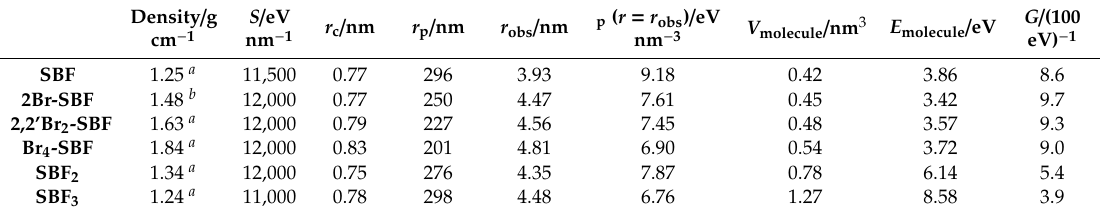
Table 2. Summary of density, calculated maximum radial range r c and r p , calculated electronic stopping power ( S ), radii in nanowire form r obs , calculated energy density at the nanowire radii ρ p ( r = r obs ) , estimated molecular volume V molecule , given energy per molecule by high-energy ions E molecule , and estimated G for SBF, 2Br-SBF, 2,2 (cid:48) Br-SBF, Br 4 -SBF, SBF 2 , and SBF 3 upon irradiation with 350 MeV 129 Xe 26 + . Data are quoted from ref. [114] © 2019, American Chemical